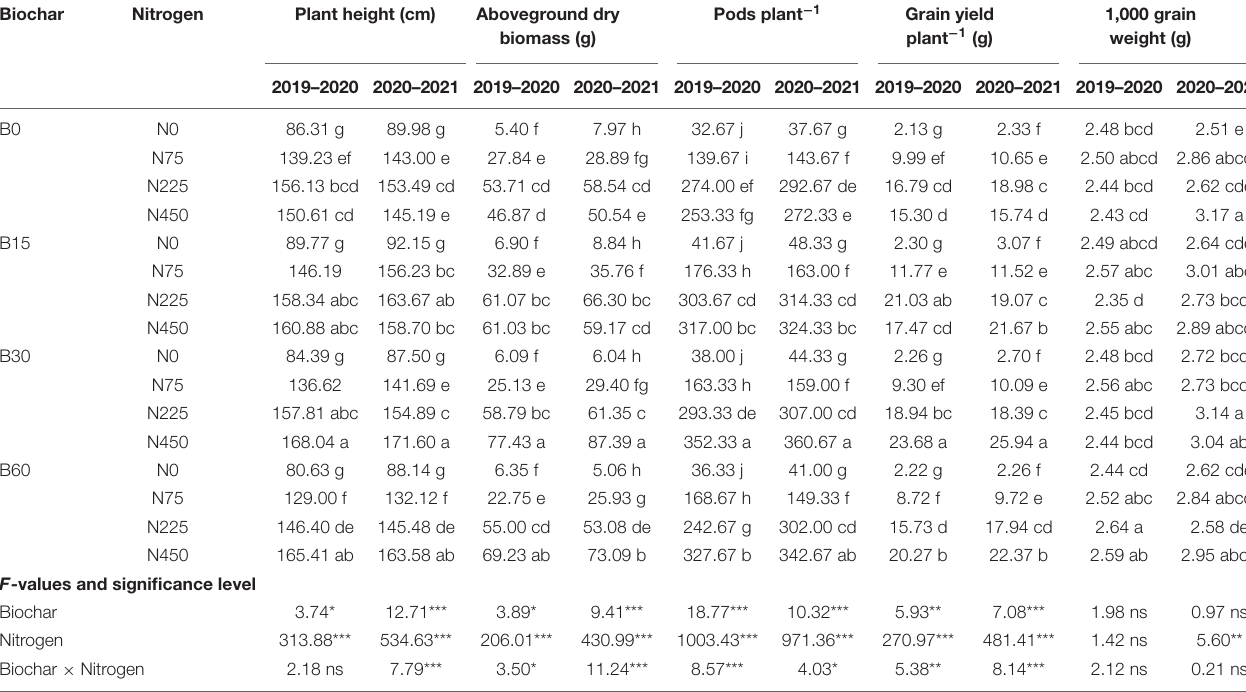
TABLE 6 | Integrated effect of biochar and nitrogen application on rapeseed growth and yield contents during 2019–2020 and 2020–2021. Biochar Nitrogen Plant height (cm)